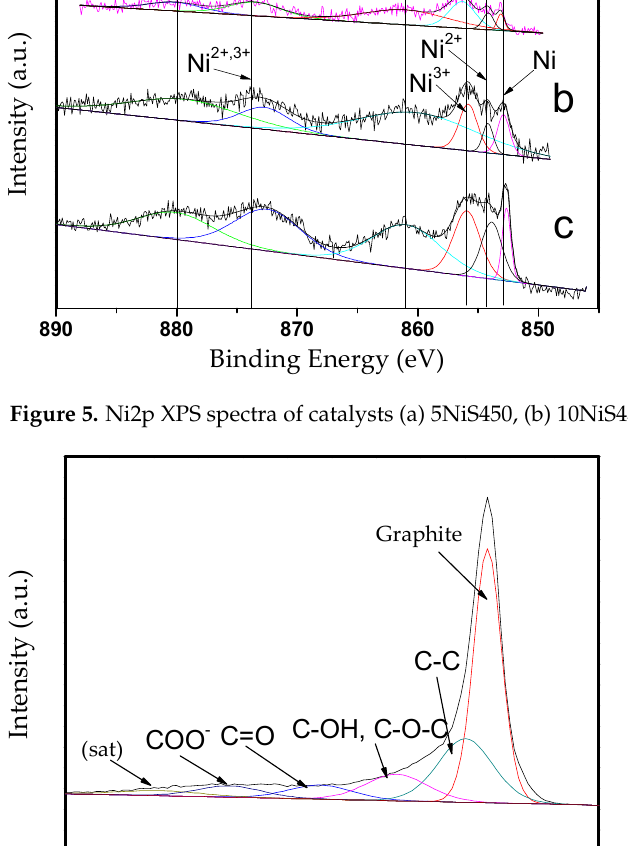
Figure 6. C1s XPS spectrum of the 10% Ni catalyst based on an S450 oxidized carbon support.